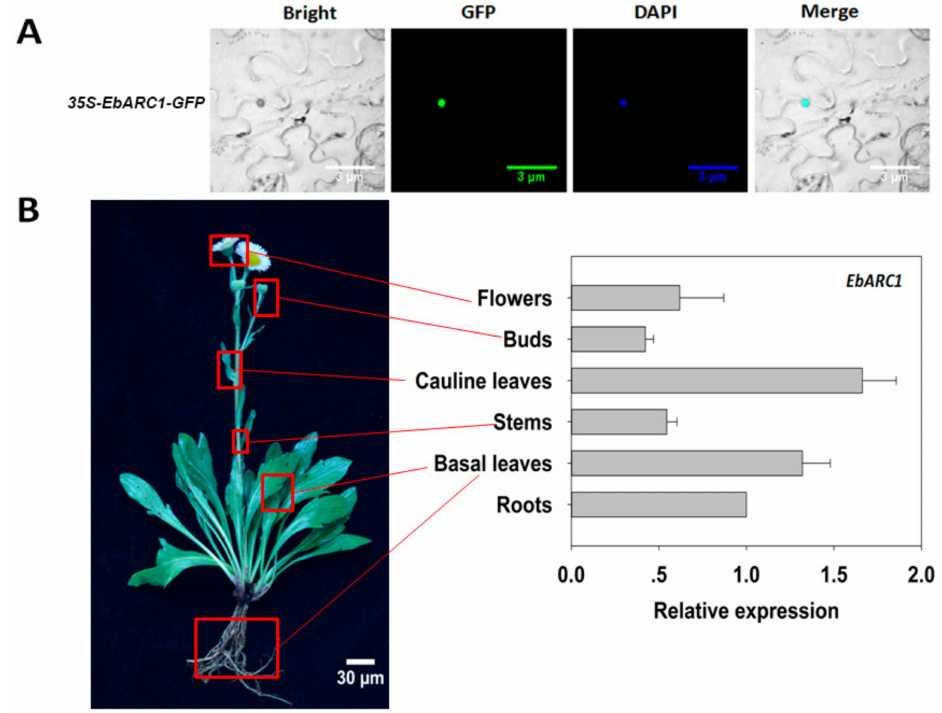
Figure 3. Expression analysis of EbARC1 . ( A ) N. benthamian leaves were infected with 35S:: EbARC1 -GFP. Bright field, GFP, DAPI, and Merge images. ( B ) The tissue-specific expression patterns of EbARC1 in flowers, buds, cauline leaves, stems, basal leaves, and roots of E. breviscapus determined by qRT-PCR